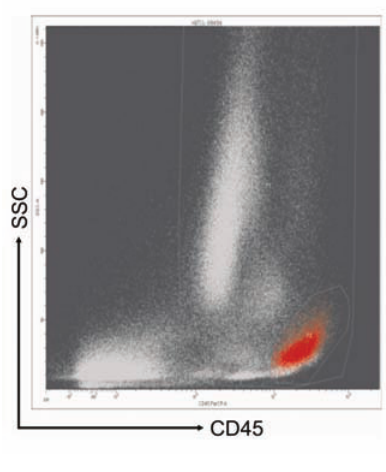
Figure 2. Flow cytometry in our patient: population of 77 % CD3 + T-lymphocytes are marked red on the CD 45 - SSC dia- gram (phenotype CD56+, CD16 partial- ly + , CD38 + , CD8 low + , CD2 + , CD7 + , CD5 – , TdT – , CD45RO + , CD161 + , intra- cellular granzyme B negative).